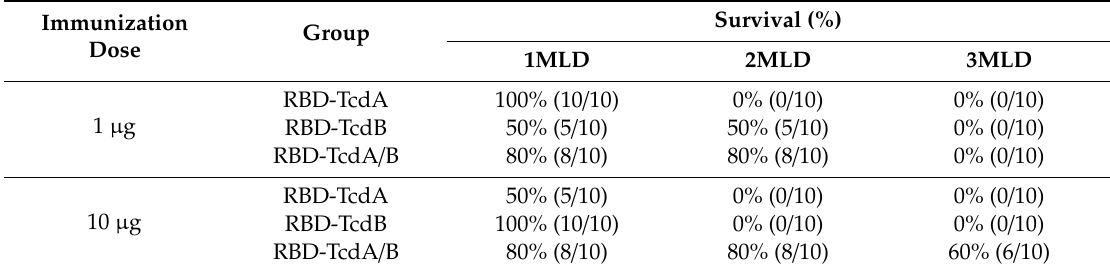
Table 2. Protection conferred by di ff erent vaccine candidates against toxins.